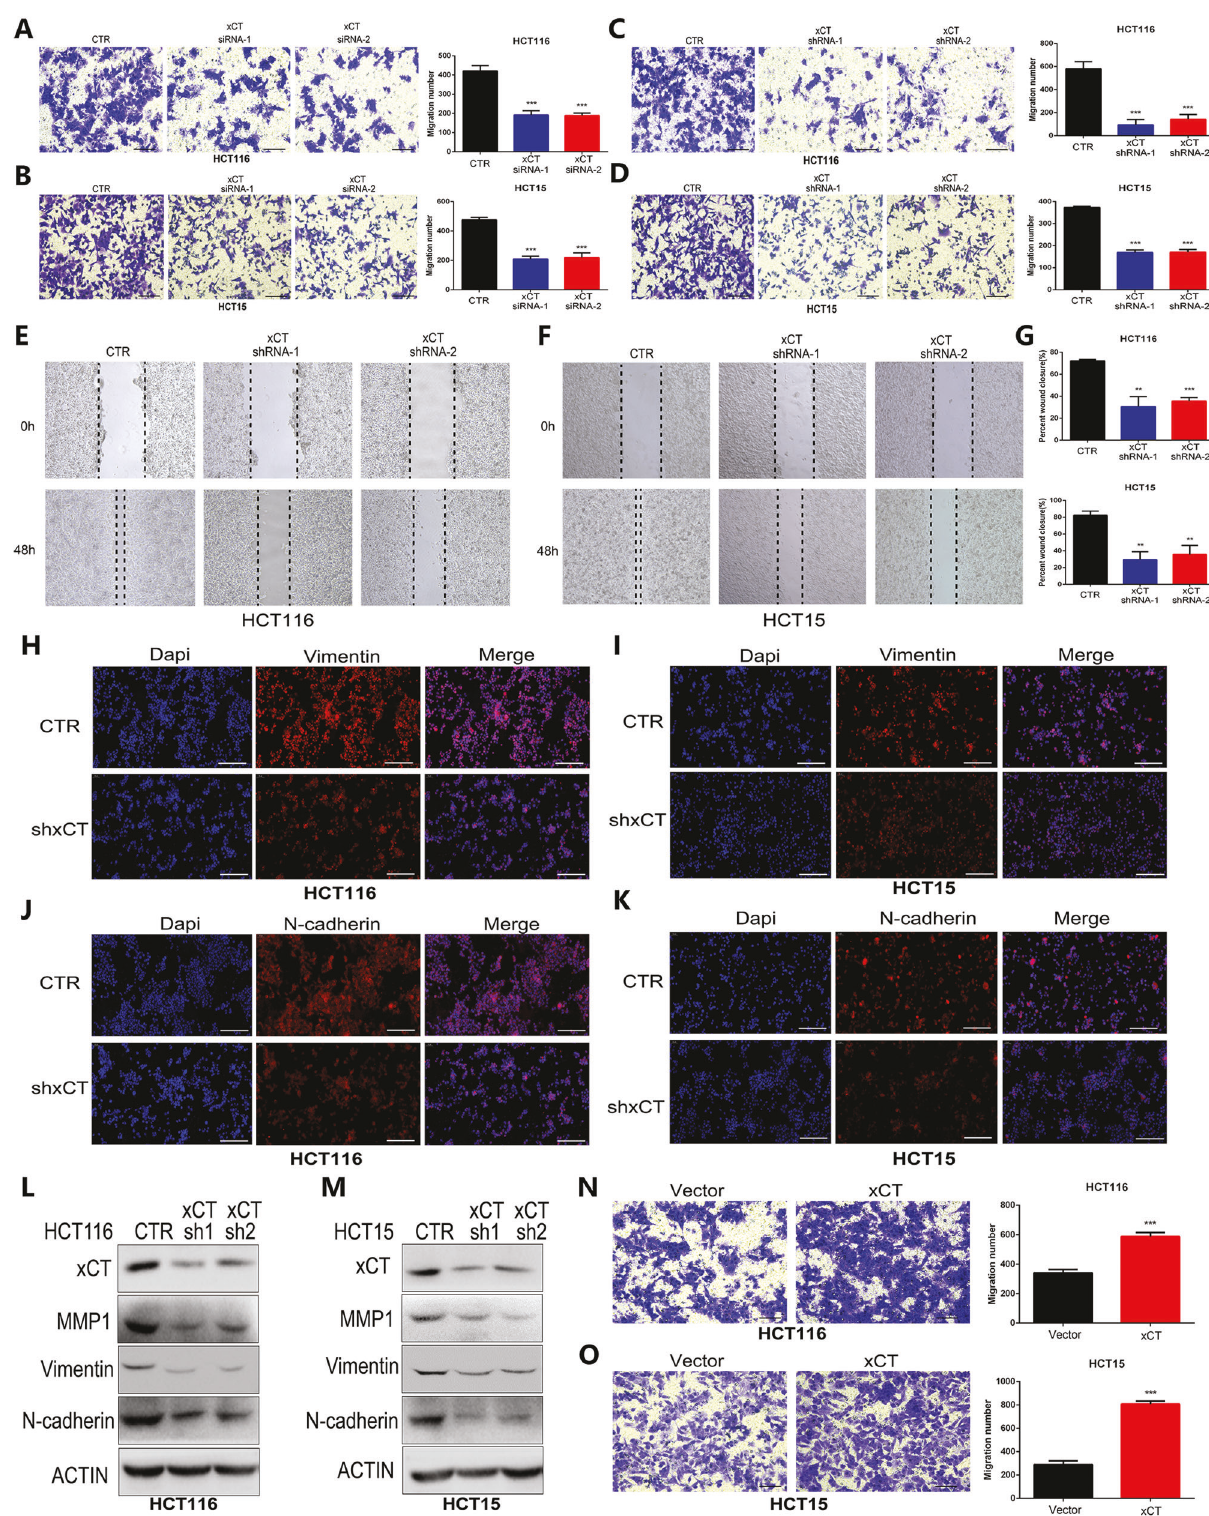
Fig. 3 Upregulation of xCT in CRC cells promotes their migration and reverses the EMT process. A – D Transwell assays indicated that xCT knockdown with xCT siRNA and xCT shRNA signi fi cantly suppressed the migration of CRC cells. E – G The wound scratch assay and quantitative analysis showed that xCT knockdown inhibited the migration of CRC cells. H – K IF staining indicated that xCT inhibition reduced the expression of vimentin ( H – I ) and N-cadherin ( J – K ) in CRC cells. L , M Western blot analysis con fi rmed that xCT knockdown decreased the expression of MMP1 and vimentin in CRC cells. N , O Transwell assays showed that overexpression of xCT promoted the migration of CRC cells. ** P < 0.01, *** P < 0.001.